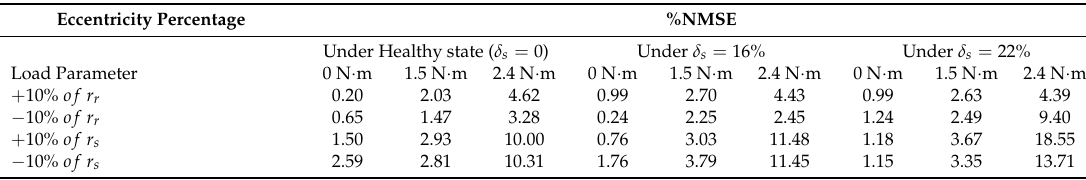
Table 3. The percentage NMSE of simulated cases.